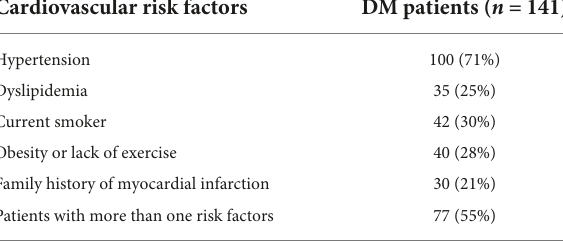
TABLE 4 The cardiovascular risk factors of T2DM patients. Cardiovascular risk factors